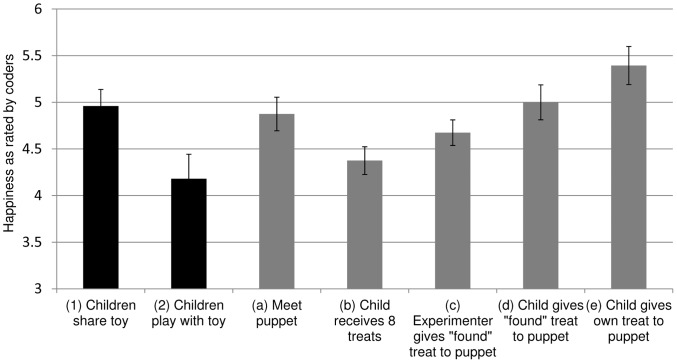
Happiness displayed in each preliminary study and main experiment condition.Happiness, as rated by coders, for children in the preliminary study and five phases of the main experiment. Error bars represent 95 percent confidence intervals around the mean.